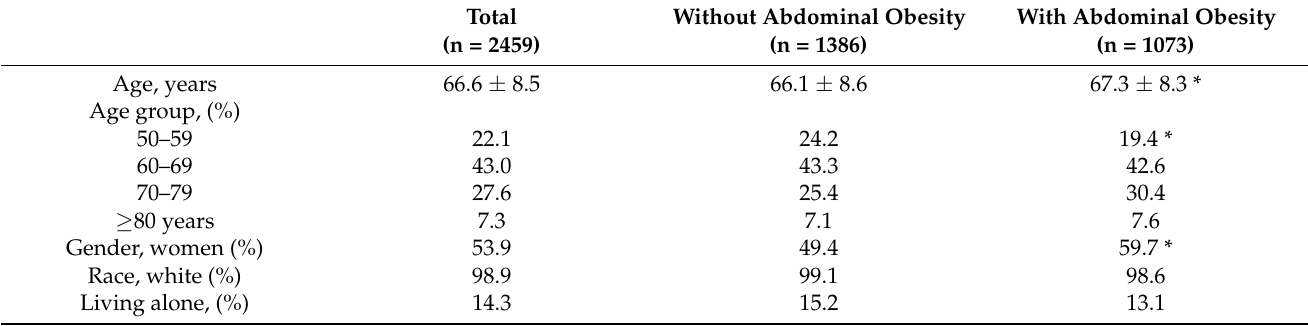
Table 1. Sociodemographic characteristics of 2459 individuals at baseline, ELSA Study (2012). Total Without Abdominal